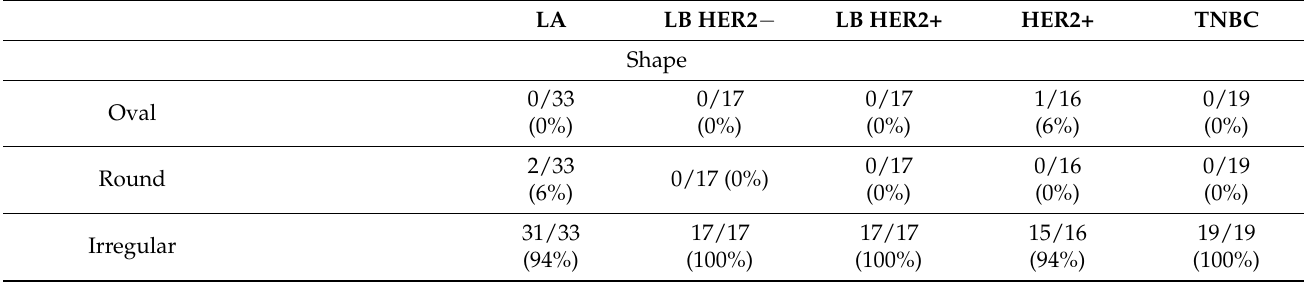
Table 4. Characteristics of specific breast cancer subtypes using BIRADS